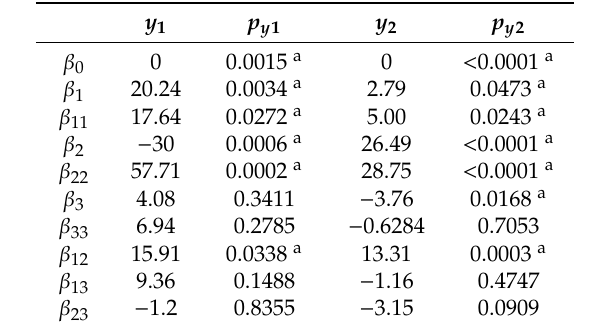
Table 3. Regression coe ffi cients and their statistical significance for variables y 1 (% of growth inhibition of A. brasiliensis ) and y 2 (% of growth inhibition of C. albicans ). ( β : regression coe ffi cients of the linear, quadratic, and interactive e ff ects of the independent variables studied). y 1 p y 1 y